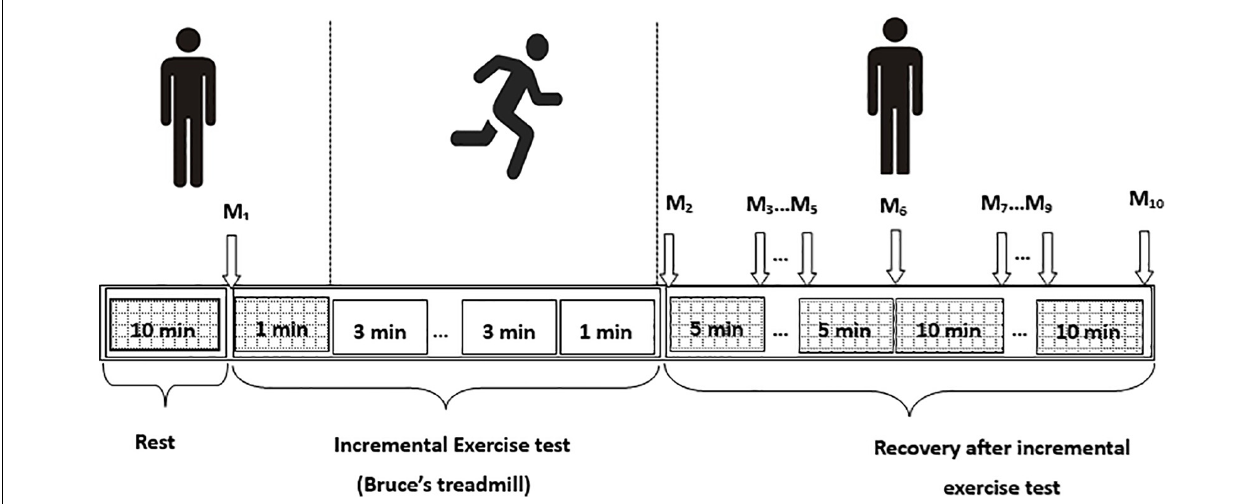
FIGURE 2 | Schematic presentation of the experimental protocol. M 1 –M 10 are the measurements before exercise and at 1–2, 5, 10, 15, 20, 30, 40, 50, and 60 min after exercise, respectively.